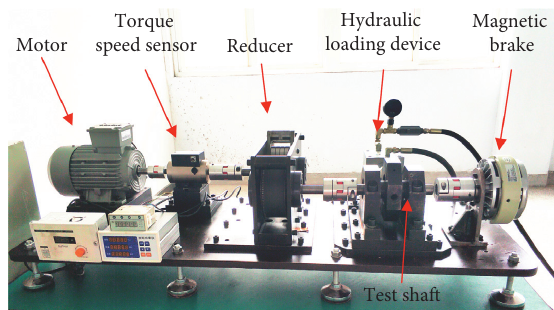
Figure 6: Signal acquisition experimental device.